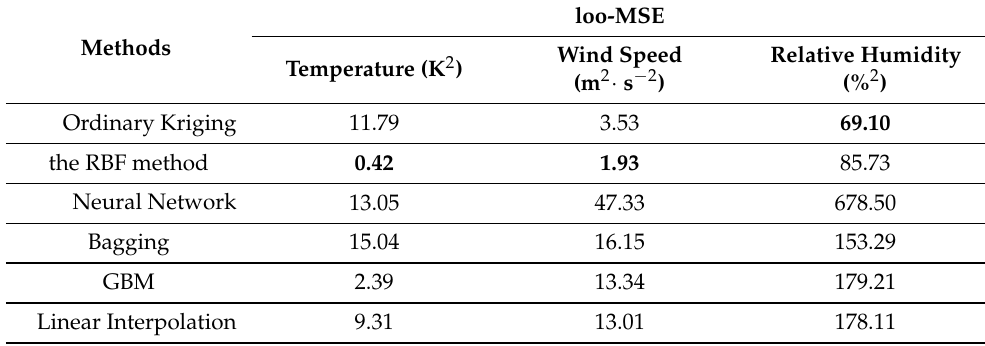
Table 3. loo-MSE for methods with GFS data along the trajectory from Prague to Tunis.